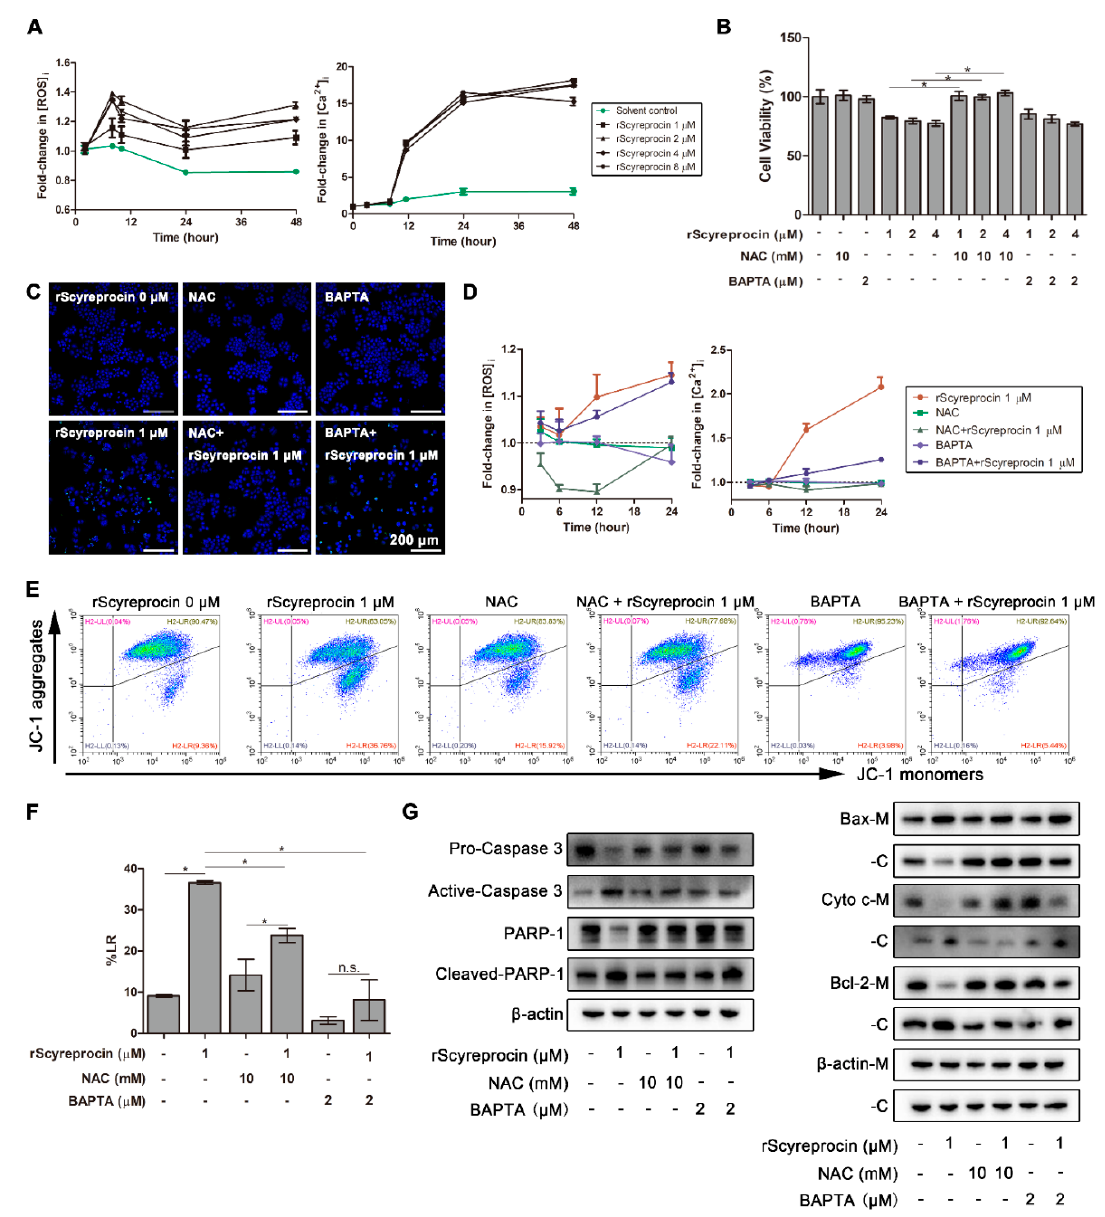
Figure 6. Recombinant scyreprocin (rScyreprocin) induced intracellular reactive oxygen species (ROS i ) production, caused mitochondria dysfunction, and led to apoptosis of H460 cells. ( A ) Fold changes in intracellular Ca 2+ and ROS levels of rScyreprocin-treated H460 cells ( n = 3). Cells were treated with rScyreprocin. Data were collected at different time points, and normalized to the reads obtained at 3 h. ( B ) Inhibitory effect of rScyreprocin on NAC pretreated H460 cells. Cells were incu- bated with rScyreprocin for 24 h in the presence or absence of prior 1 h incubation with 10 mM NAC, and were evaluated for cell viability ( n = 3). ( C ) Apoptotic effect of rScyreprocin on NAC and BAPTA pretreated H460 cells. Cells were treated with 1 μ M rScyreprocin for 24 h in the presence or absence of prior 1 h incubation with NAC or BAPTA, respectively. In situ cell death was determined by TUNEL assay. ( D ) Effect of rScyreprocin on intracellular Ca 2+ and ROS levels. Samples were pre- pared as described in ( C ) and evaluated for fold changes in intracellular ROS and Ca 2+ levels, re- spectively ( n = 3). ( E ) Effect of rScyreprocin on mitochondrial membrane potential of H460 cells. Samples were prepared as described in ( C ), subjected to JC-1 staining, and analyzed with flow cy- tometry ( n = 3). ( F ) Statistical analysis of the data presented in ( E ). ( G ) Expressions of apoptosis- related proteins in rScyreprocin-treated H460 cells. Samples were prepared as described in ( C ). Ex- pressions of apoptosis-related proteins in whole cell lysate (left panel) and expressions of Bax, cyto- chrome c, and Bcl-2 in mitochondrial (M) and cytosolic (C) fractions (right panel) were determined. The experiments were carried out in three different occasions ( n = 3) and quantified using Image J